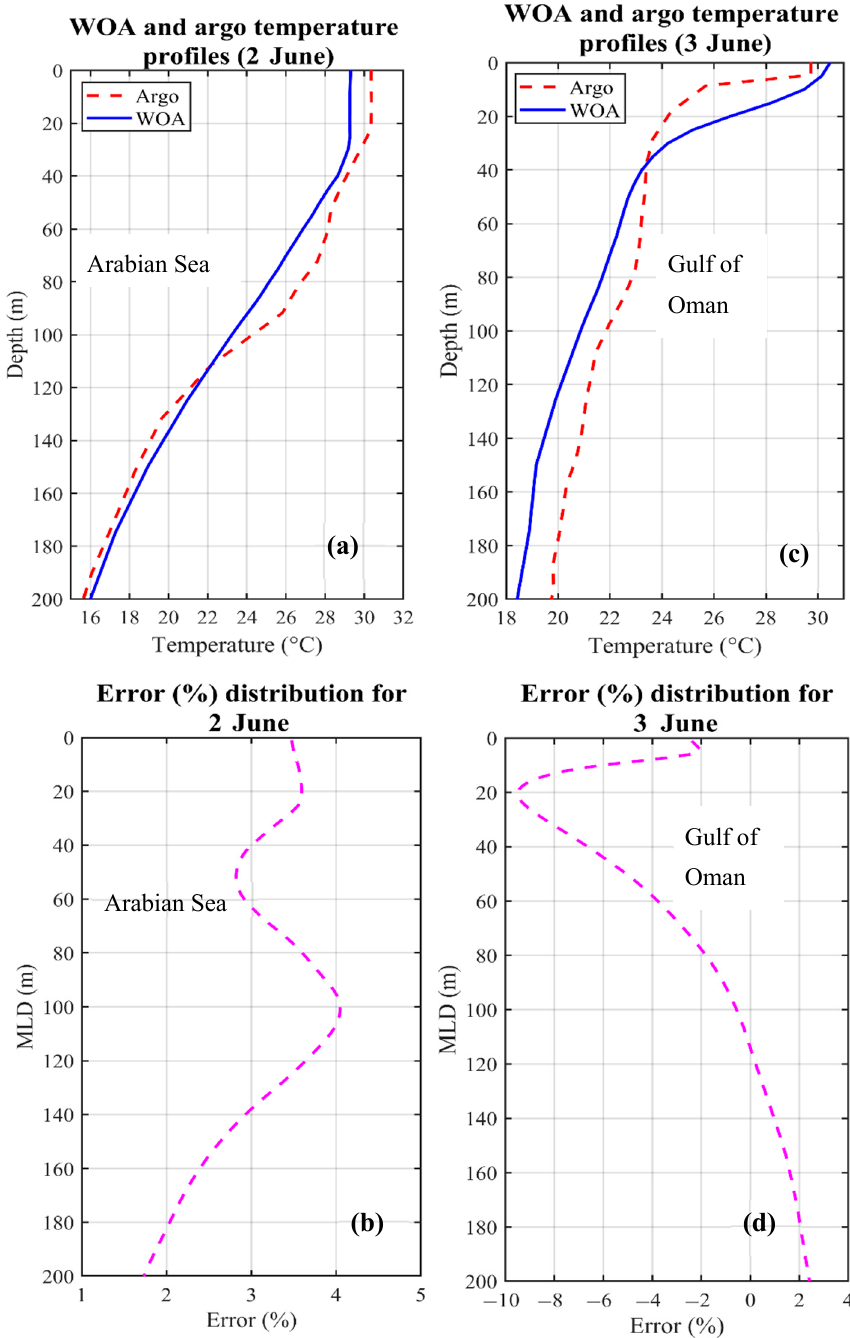
Figure 13. ( a , c ) Comparison of WOA and Argo temperature profiles on 2 June and 3 June in the northern Arabian Sea and the Gulf of Oman; ( b , d ) relative temperature differences (%) across the water column for profiles shown in ( a , c ).